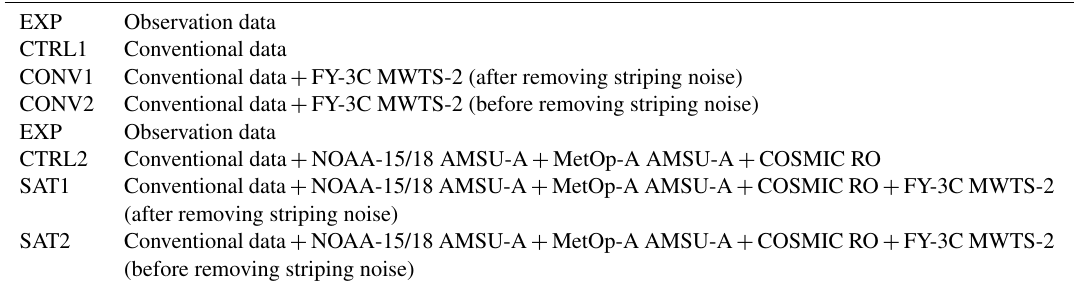
Table 3. Experimental design for the six cycle